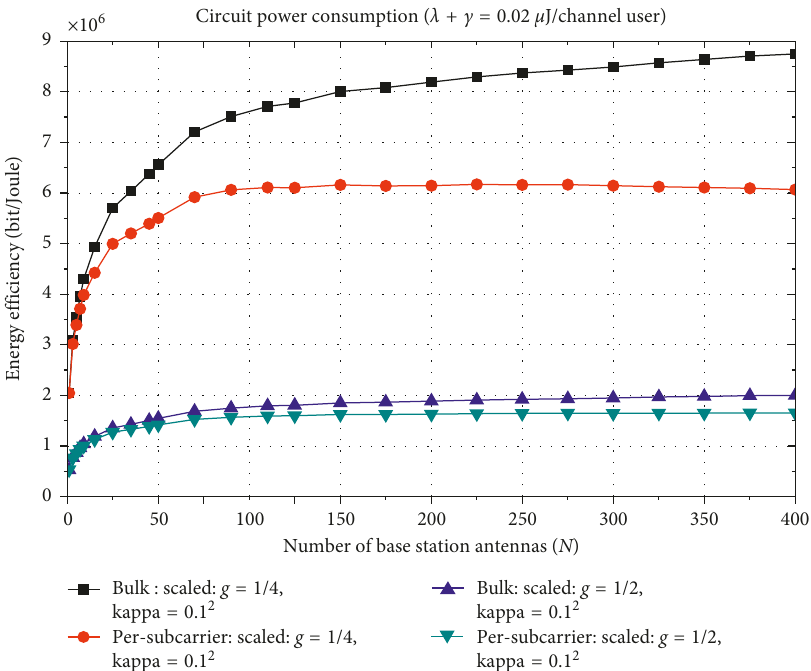
Figure 4: Energy efficiency of the massive MIMO-OFDM channel versus the number of BSA for per-subcarrier selection and bulk antenna selection techniques using various power scaling factors ( g c power ( λ 0.02 µ J/channel user). + (cid:31)